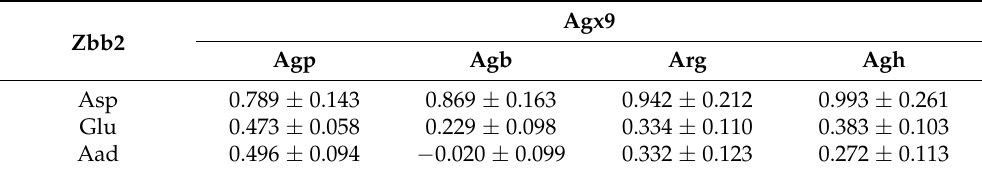
Table 2. The folding free energy ( ∆ G fold , kcal/mol) for the HPDZbbAgx peptides.